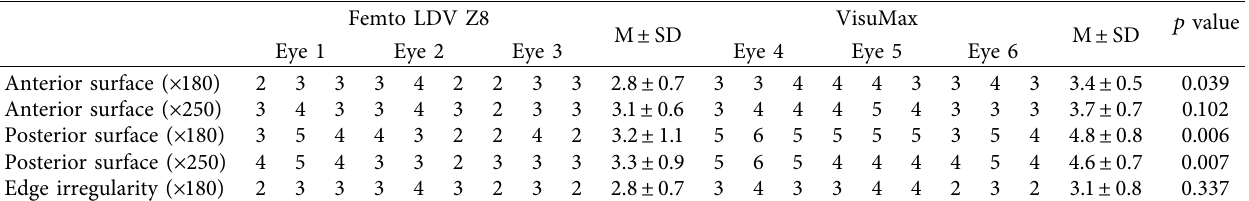
Table 4: SEM image scoring of the lenticule surface roughness and edge